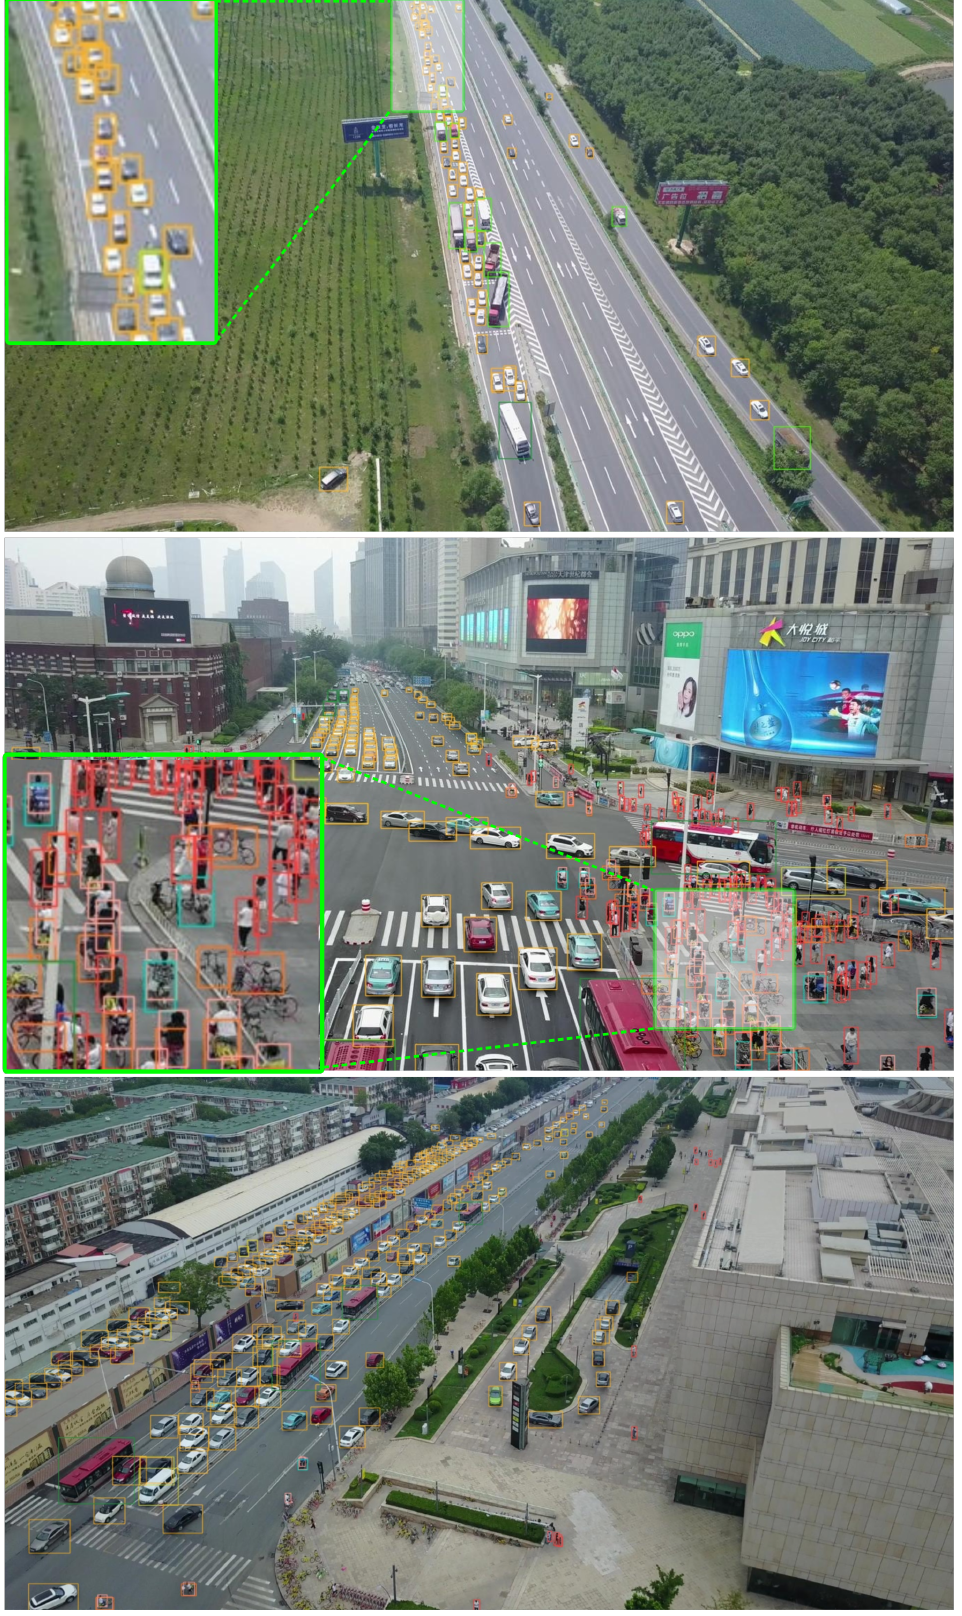
Figure 9. Visualization of the detection results obtained with our